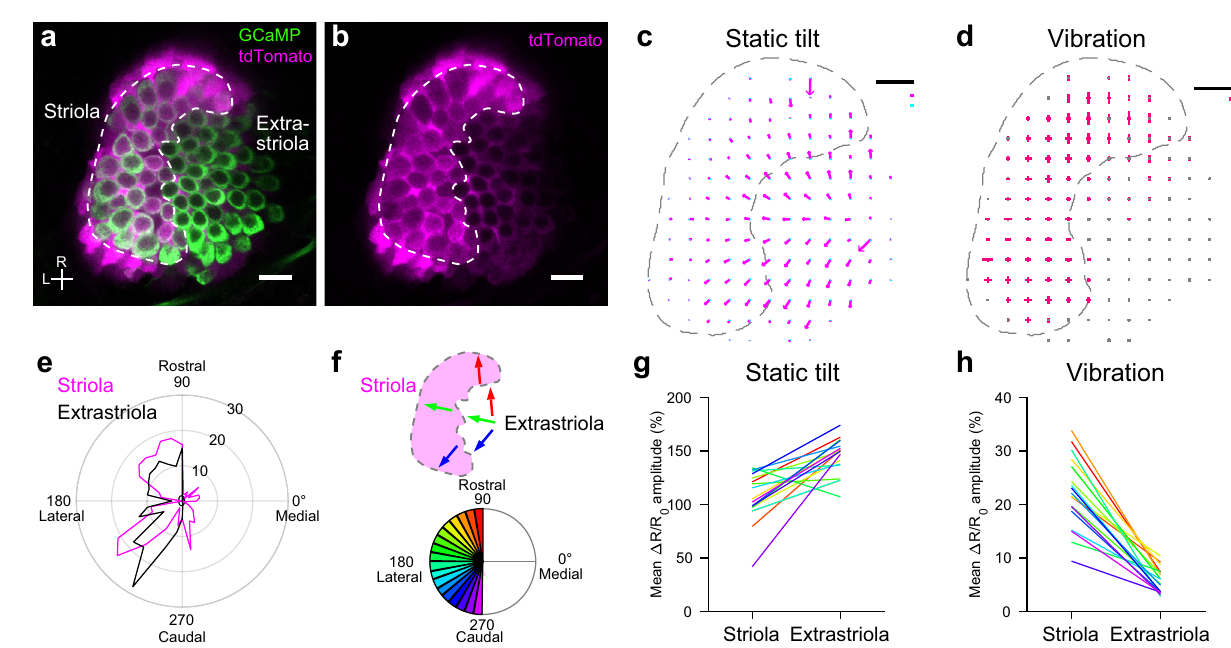
Δ R / R Δ R / R 0 amplitude, respectively. Magenta scale bar: 20% 0 . e Polar histogram showing number of HCs (radial axis) against HCpolarity(angular axis) determined byorientationoftiltresponsevectors.Binsize:10°. f ExampleofHCgroups,eachof which has a similar polarity (top). Color code for HC polarity groups with bin size 10° (bottom). g , h Pairwise comparison of mean Δ R / R 0 response vector length between striolar and extrastriolar HCs in 6 utricles (18 HC polarity groups). Color codeshownin( f ).Two-sidedWilcoxonsigned-ranktest( g , p =1.1×e − 4;h, p =7.6× e − 6). Source data are provided as a Source Data fi